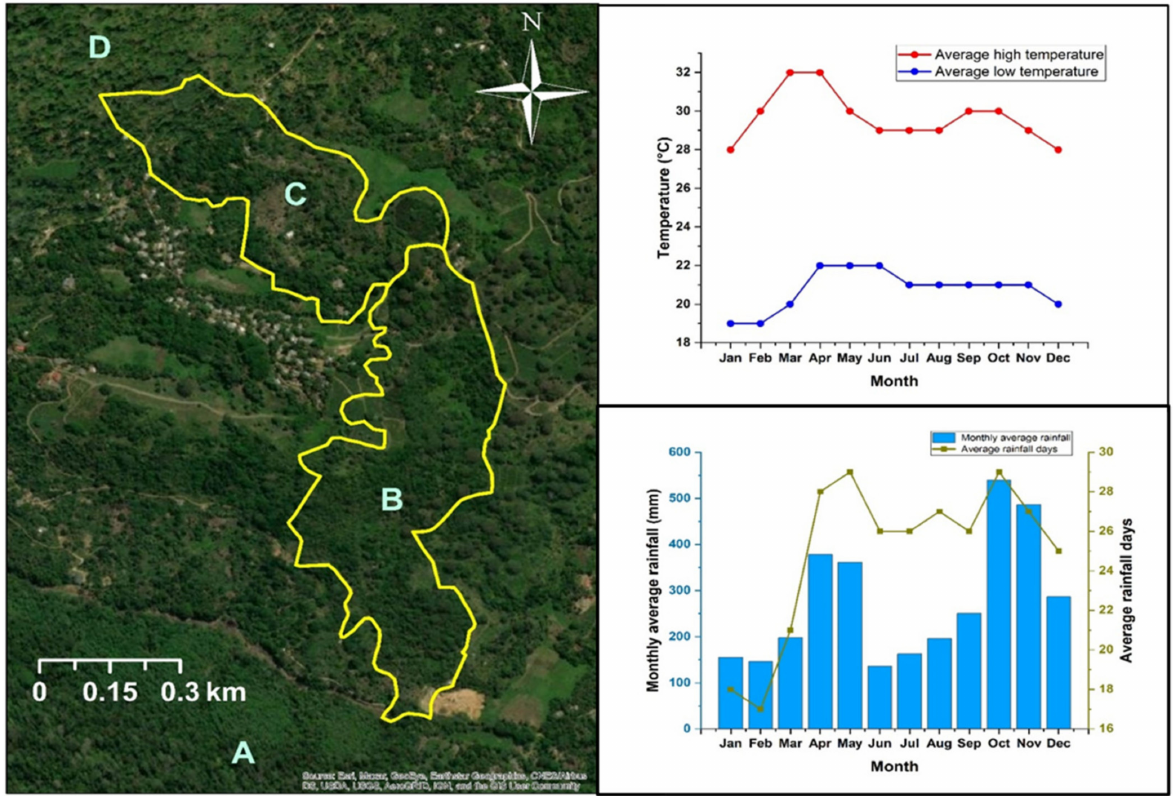
Figure 1. Map of the Endane Biodiversity Corridor (EBC), Dilmah Conservation and Kahawaththa Plantations PLC., located adjacent to the Sinharaja Rainforest Complex in the Rathnapura District of Sri Lanka. Letters denote: A—Sinharaja Rainforest Complex, B—lower part of the EBC where the current study was conducted, C—agroforests in the upper part of the EBC, D—Iharakanda Proposed Forest Reserve. Monthly temperature and rainfall variation are shown in the panels on the